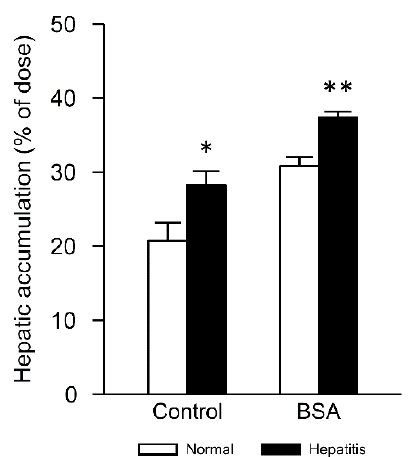
Figure 6. E ff ect of hepatitis on hepatic accumulation of lipoplex after i.v. injection in mice. Lipoplex was incubated with 5% glucose (control) or BSA for 5 min before injection. Each bar represents the mean + SD of 3 experiments. Statistical method, Student’s t -test. * p < 0.05, ** p < 0.01 vs. normal.